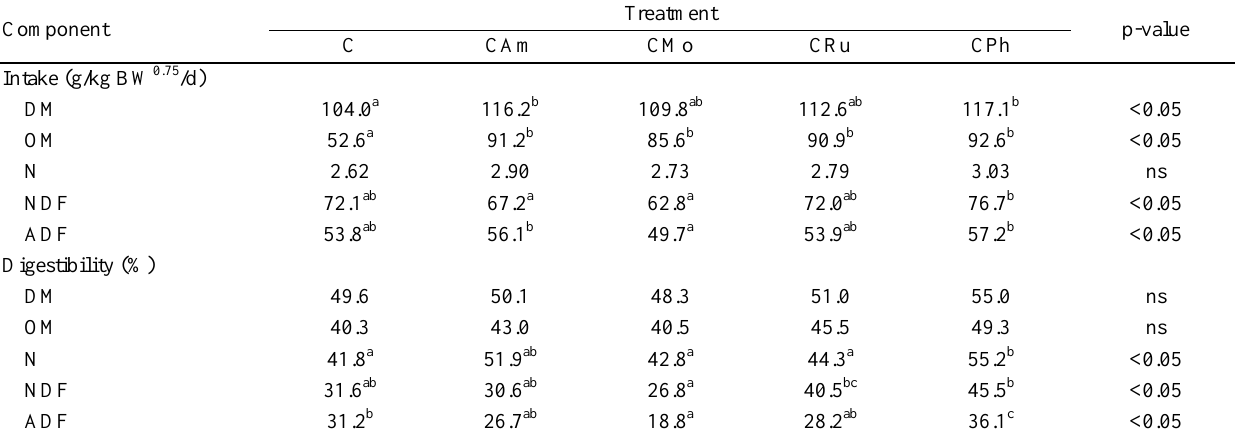
BW, body weight; DM, dry matter; OM, organic matter; N, nitrogen; ns, non-significant; NDF, neutral detergent fiber; ADF, acid detergent fiber. 1 C, cocoa pod without any treatment; CAm, ammoniated cocoa pod with 1.5% urea; CMo, fermented cocoa pod with 3% molasses; CRu, fermented cocoa pod with 3% rumen content; CPh, fermented cocoa pod with 3% molasses and Phanerochaete chrysosporium inoculum. Different superscripts within the same row are significantly different at p<0.05.